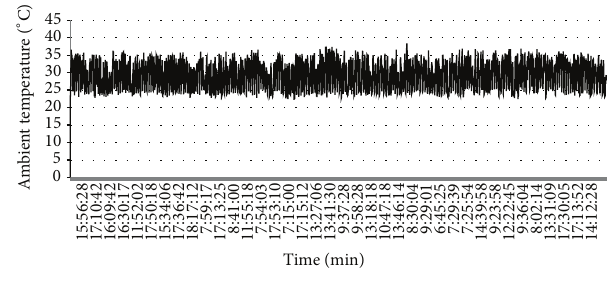
Figure 4: Ambient temperature pattern for 10